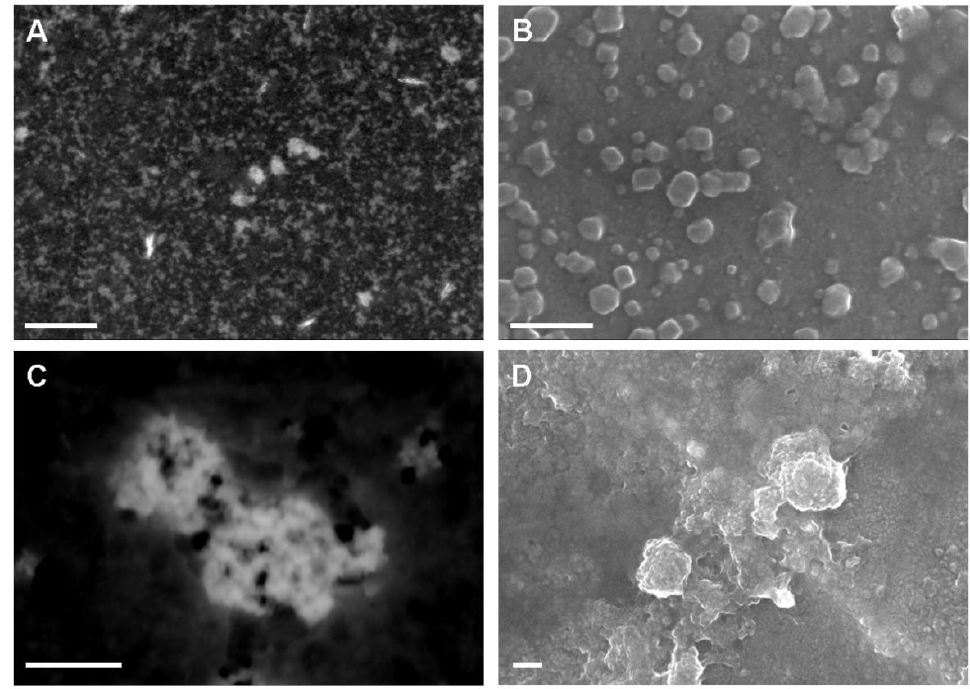
Figure 2. Annular dark field (ADF)-STEM (left) and SEM (right) images of nanoFos ( A , B ) and of CH-nanoFos. ( C , D ). Scale bar is 200 nm.